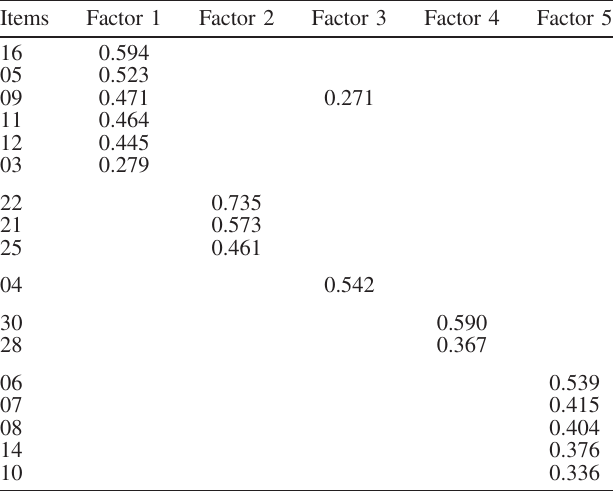
TABLE VII. Initial five-factor loadings for group B. Loadings less than 0.25 have been suppressed. EFA involved approxi- mately half of the section 1 students. These loadings represent results after a filtering of the original 30 items.